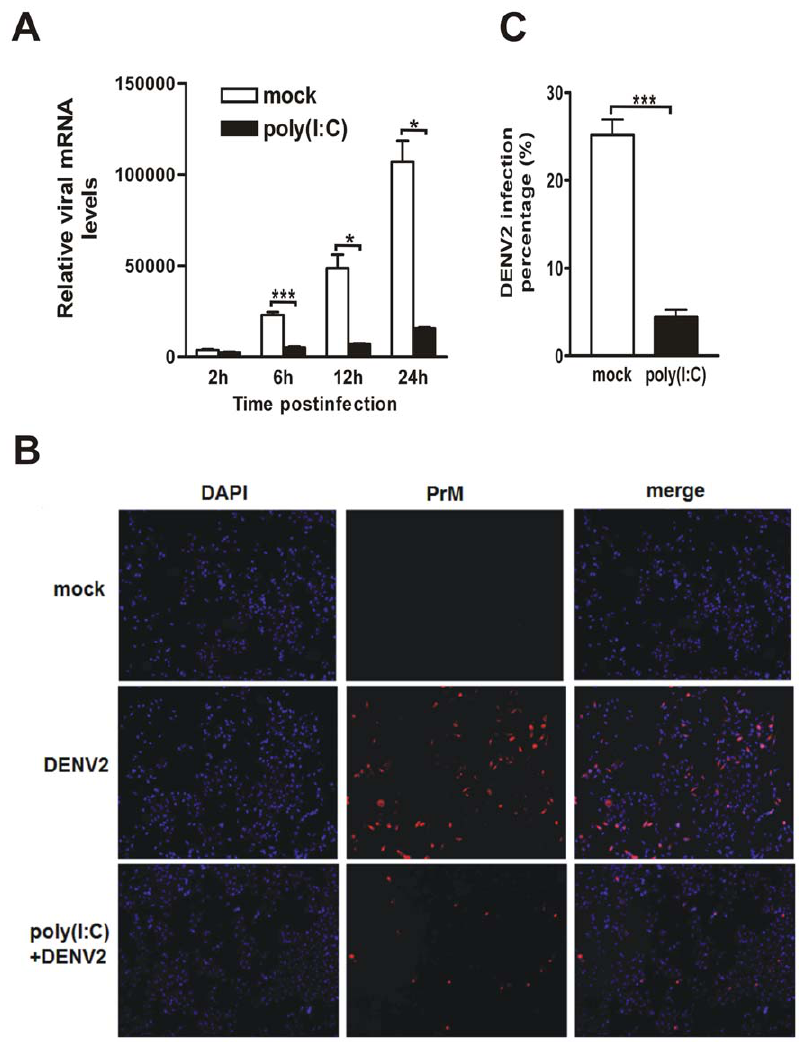
Figure 2. Pretreatment of poly(I:C) suppresses the DENV2 replication in HepG2 cells. HepG2 cells were mock- or pretreated with 5 m g poly (I:C) for 9 h, then infected with DENV2. (A) Real-time PCR to measure viral mRNA levels. Total RNAs were harvested at 2, 6, 12, and 24 h p.i., and used for real-time RT-PCR. (B) Immunofluorescence microscopy. Infected cells were fixed at 24 h p.i. and incubated with DENV2 prM antibody. (C) Percentages of positive-stained cells determined by PicCnt 100 6 . Error bars represent the standard error of mean from the average of three experiments. Student’s t test, *, p , 0.05; ***, p , 0.001.